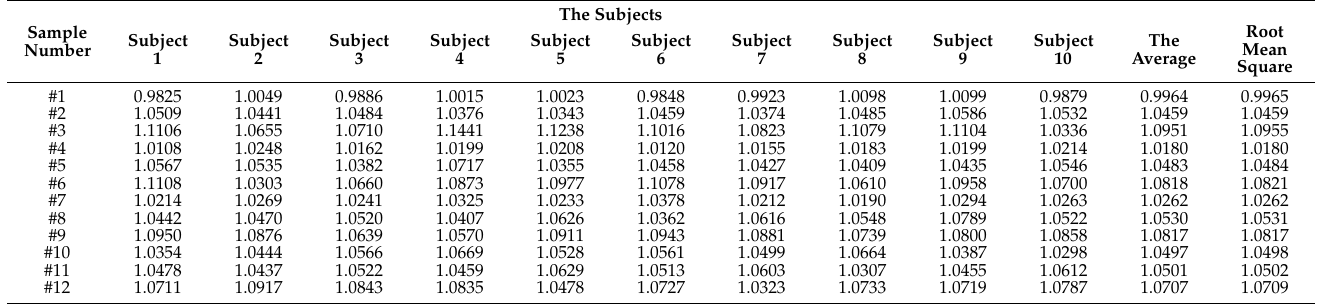
Table 4. The blood flow promotion multiples of skin–blood microcirculation.